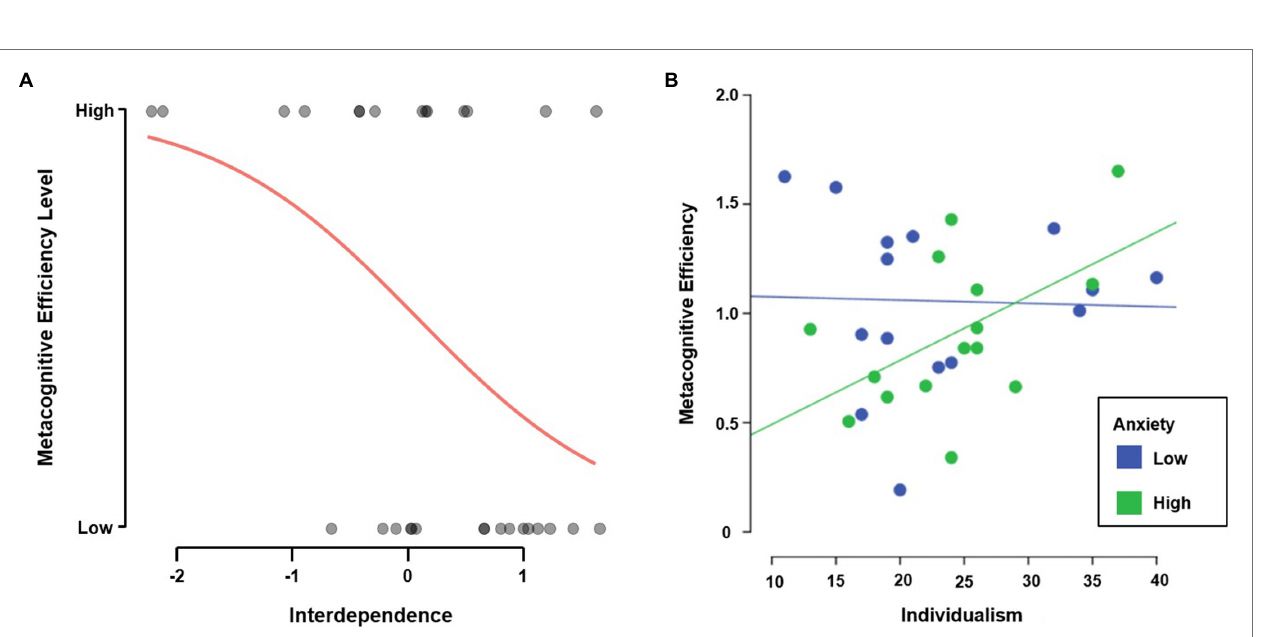
FIGURE 2 | (A) Logistic regression of interdependence on metacognitive efficiency levels. (B) Regression of individualism on metacognitive efficiency by self- reported anxiety levels. N = 30.